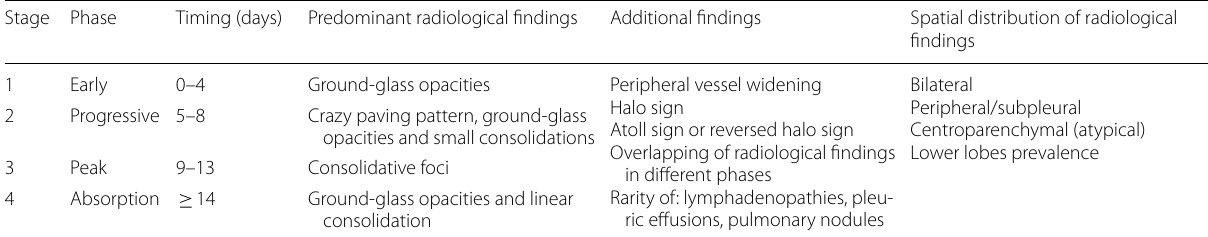
COVID-19 pneumonia has been divided into four stages, according to Feng Pan [12], depending on the timing of typical radiological findings occurrence. Spatial distribution of radiological findings and additional findings is of primary importance to reach a correct diagnosis [12, 14, 15]